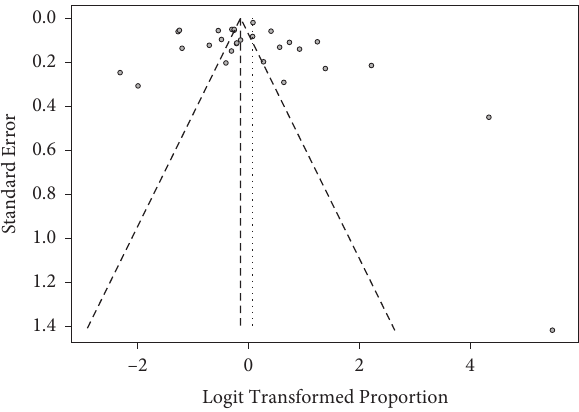
Figure 3: Funnel plot of the selected